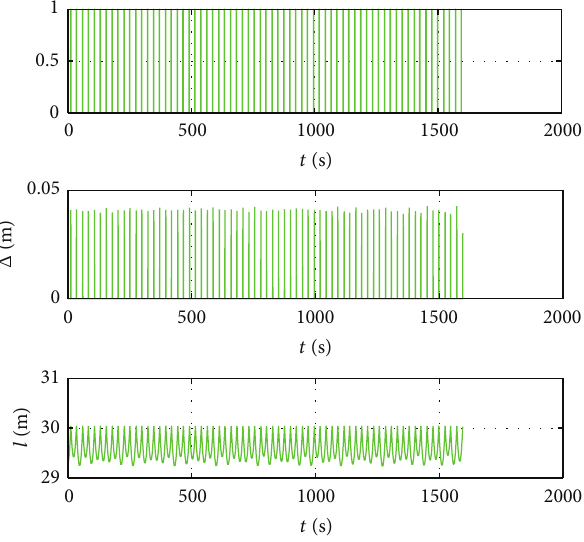
Figure 24: The tensional and tensionless states, the elongation of the tether, and the distance between the two spacecraft.